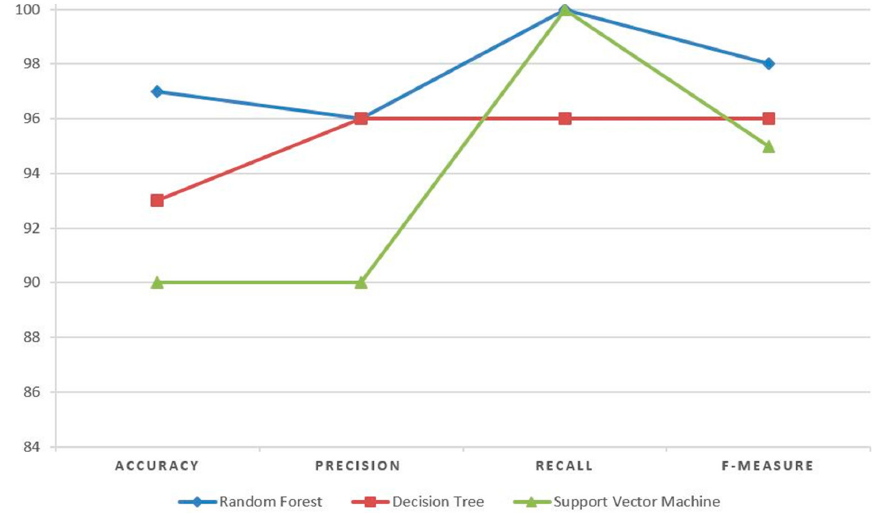
Figure 6. Performance measure graph of different algorithms.